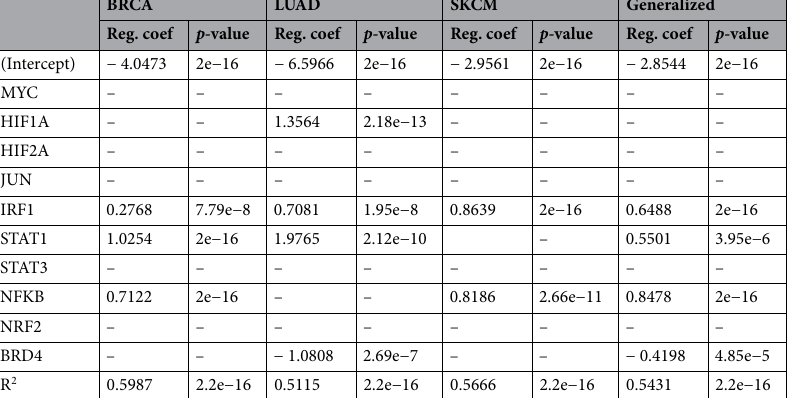
(Fig. 1c–l). Interestingly, the expression of PD-L1 followed a similar pattern (Fig. 1m), while its expression data were not used in the generation of the t-SNE plots. Indeed, CD274 expression levels were substantially different between the activity of some of the TFs and the expression of PD-L1.